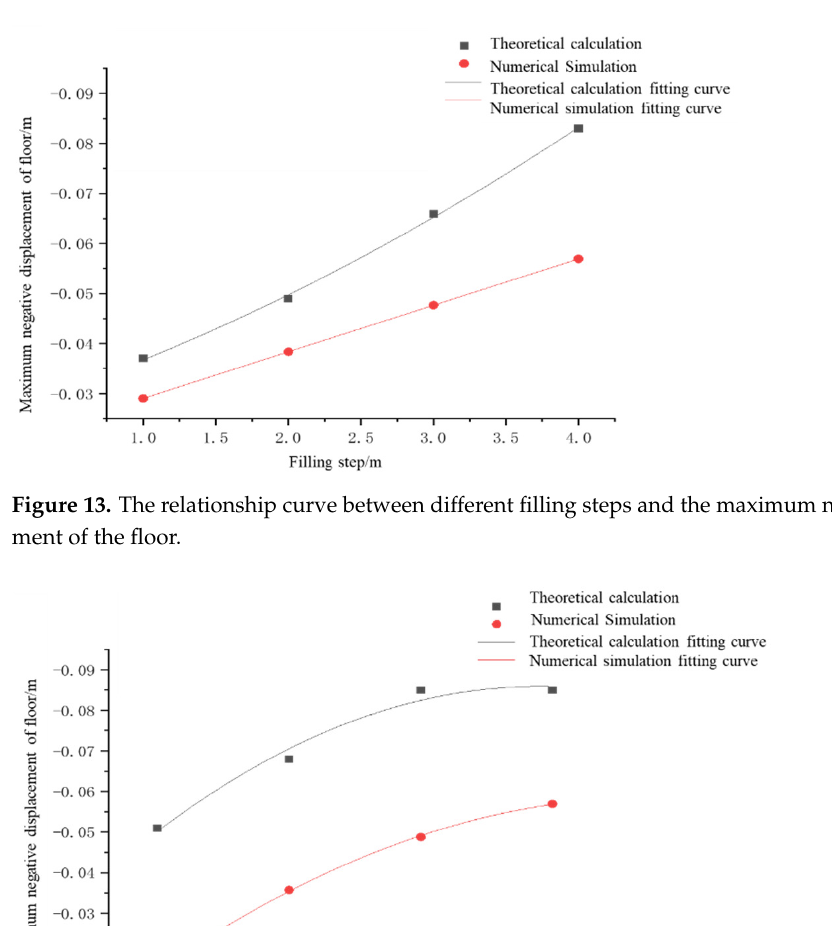
Figure 12. The relationship between different filling steps and the maximum positive displacement of the floor.